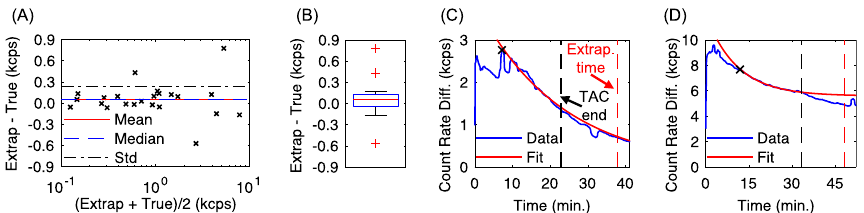
Fig. 3 Validation of the topical detector TAC extrapolation method, assuming 15 min gap between the end of the TAC and the extrapolation time point. A Bland–Altman plot of extrapolated ( ˆ D ) and ground truth measurements. B Box plot of differences between extrapolated and ground truth measurements, with central line indicating the median, box bottom and top edges representing the 25th and 75th percentiles, respectively, whiskers indicating the extremes, and red crosses indicating outliers. C , D Representative fits for cases with ( C ) minimal count rate bias and ( D ) outlier count rate bias due to a baseline shift after the assumed TAC end time, with automated fit start time indicated by “x” marks in both cases